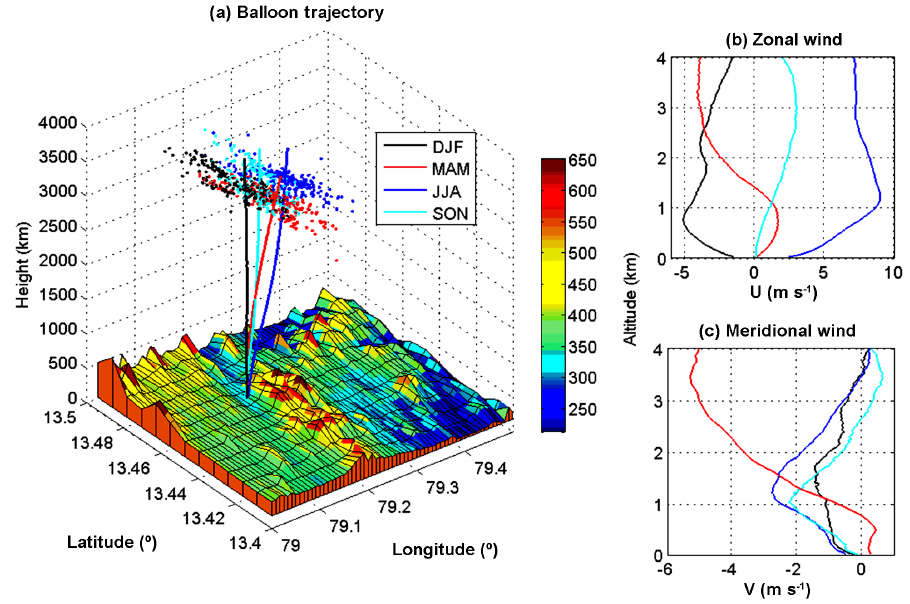
Figure 1. (a) Topographical features surrounding the location of radiosonde launch site, Gadanki (13.45 ◦ N, 79.2 ◦ E), a tropical station in India, along with profiles of seasonal mean trajectories (thick lines) from the surface to 4km and the locations of the balloon reaching at altitude 4km (dots) during different seasons. The mean (b) zonal wind and (c) meridional winds for different seasons observed during the period December 2010–March 2014. Global 30arcsec gridded topography data are provided by the National Centre for Environmental Information,